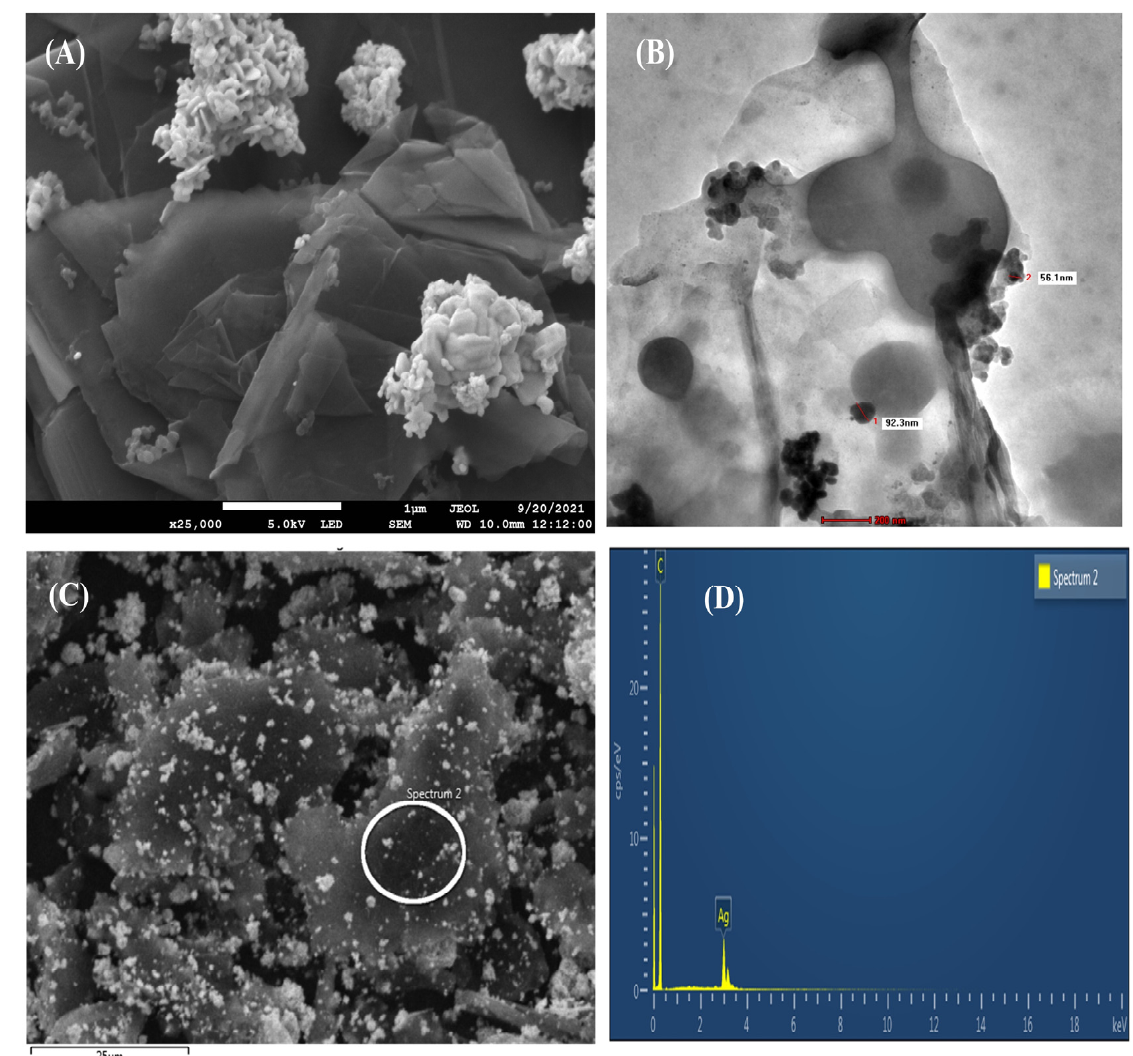
Figure 3. FESEM image of hybrid nanofillers ( a ) magnification 25,000 ( b ) TEM image of the HNePCMs ( c , d ) EDX mapping of hybrid nanoparticles.